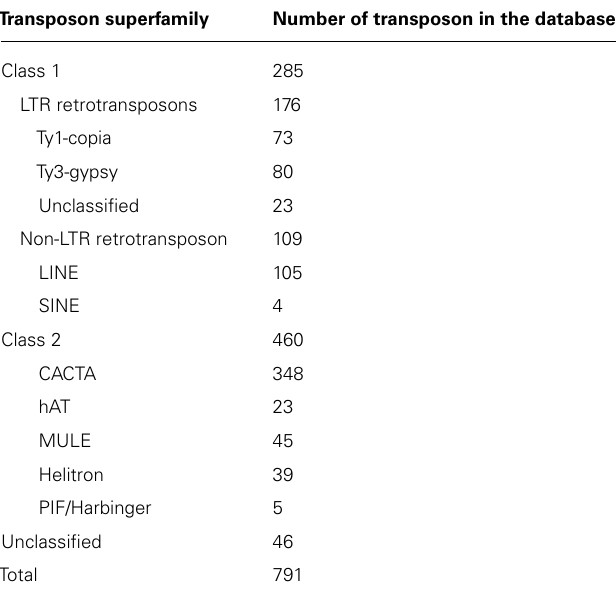
Table 1 | Summary of the common bean transposon